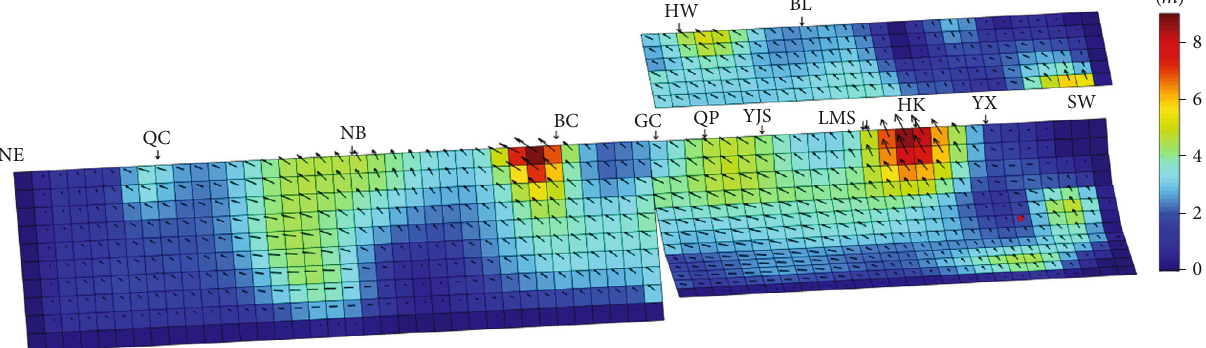
Figure 4: The slip distribution of the 3D model of Wenchuan earthquake based on inversion of GPS data. The characters are the towns. BL: Bailu; HW: Hanwang; YX: Yingxiu; HK: Hongkou; LMS: Longmenshan; YJS: Yuejiashan; QP: Qingping; GC: Gaochuan; BC: Beichuan; NB: Nanba; QC: Qingchuan. Table 2: The inversion